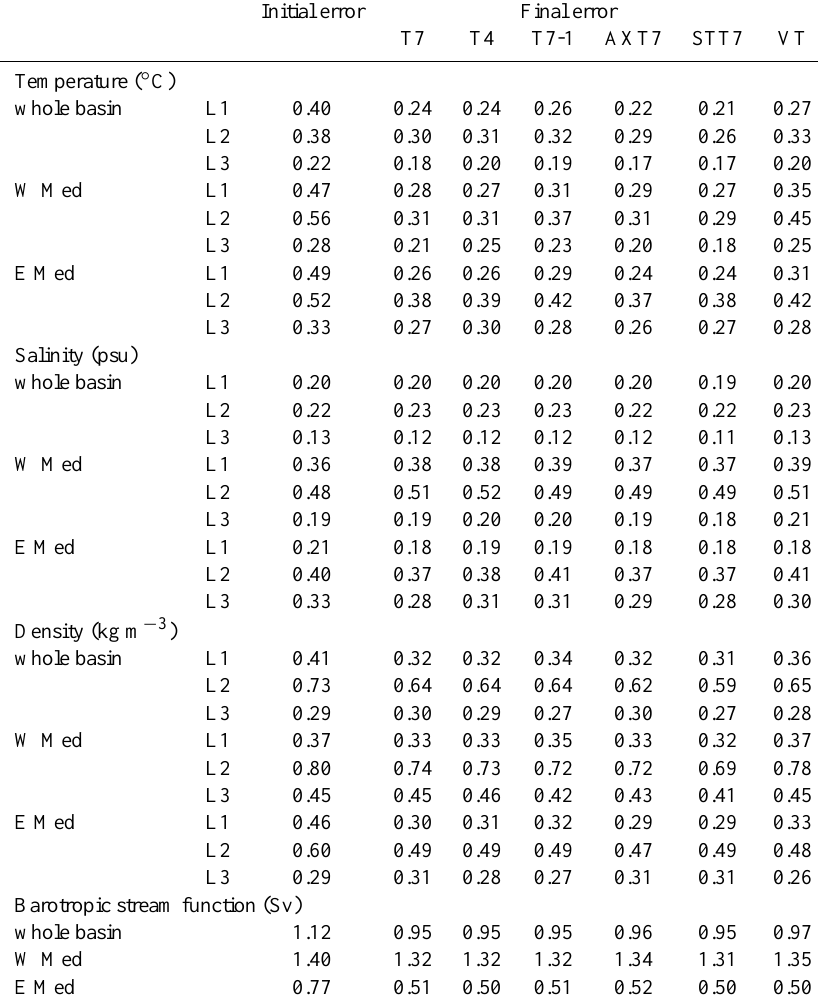
Table 6. Winter OSSEs: Initial and final errors in the assimilation runs relative to the control run for selected sampling strategies (T7, T4, T7-1, AXT7, STT7, VT) arranged by parameter (temperature, salinity, density, barotropic stream function), basin (whole, western, eastern Mediterranean) and layer (L1, L2,